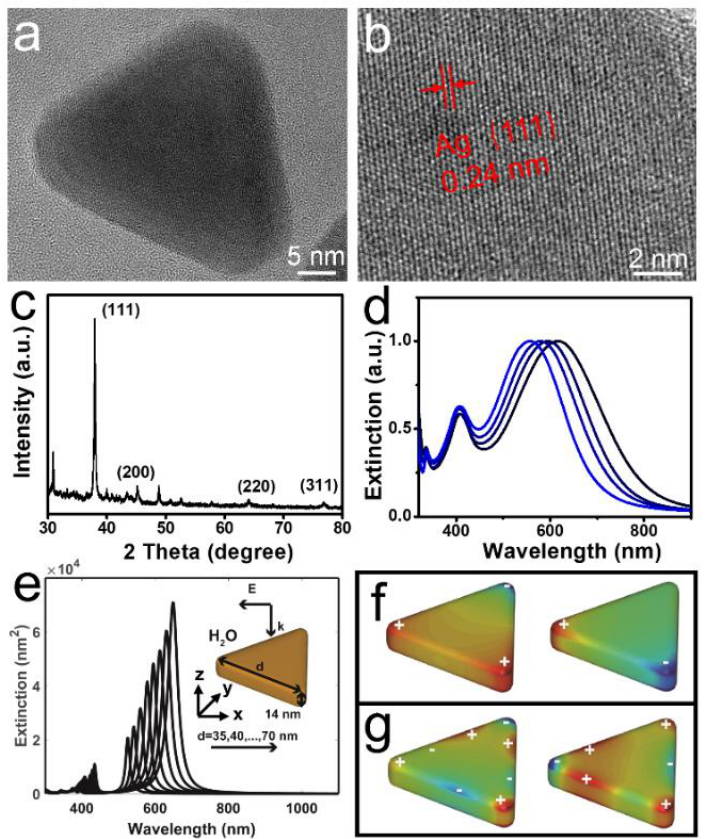
Figure 1. Characterization of silver triangle nanoplates. ( a ) Typical TEM image of single Ag NP. ( b ) HRTEM image of Ag NP. ( c ) XRD of Ag NPs. ( d ) UV-vis extinction spectra of Ag NPs. UV-vis extinction spectra showed three LSPR bands, corresponding to the in-plane dipolar resonance, and out-of-plane multipolar resonance, respectively. Additionally, the maximum SPR band is localized at 620 nm, which is sensitive to the injected amounts of seeds. It will blue-shift from 620 nm to 556 nm as the volume of seeds changes from 250 µ L to 700 µ L. ( e ) Computed extinction cross-section of Ag NPs (inset of ( a )) with a thickness of 14 nm and various length in water, which are illuminated by a plane-wave propagating along negative z -axis and polarizing along the x -axis, as indicated in the inset. ( f , g ) The surface charge distribution (blue for negative charge, and red for positive charge) associated with the plasmon peaks at longer ( f ) and shorter wavelengths ( g ), as marked in ( e ), for an Ag nanoplate with a length of d = 53